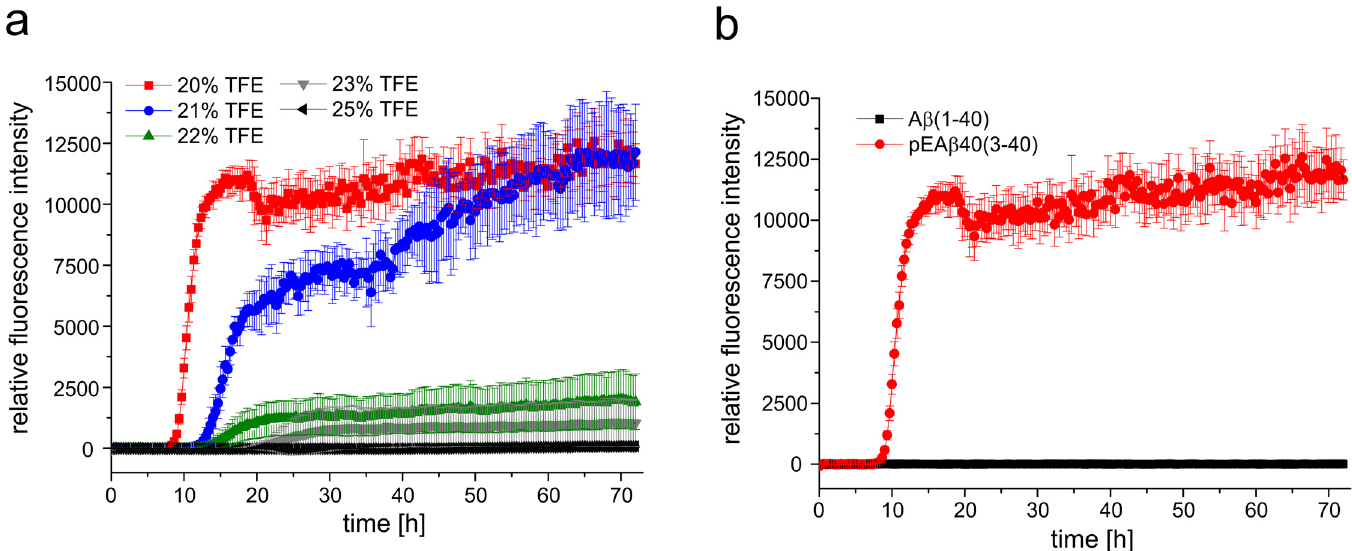
Fig 2. Aggregation kinetics of pEA β (3 – 40) and A β (1 – 40) in TFE. (a) 25 μ M of monomerized pEA β (3 – 40) were dissolved in buffer with various TFE contents (25%, 23%, 22%, 21% and 20% TFE in 50 mM potassium phosphate, pH 2.8) including 10 μ M ThT. pEA β (3 – 40) aggregated in 20% and 21% TFE but was significantly decreased in aqueous solution with higher TFE concentration. (b) 25 μ M of monomerized pEA β (3 – 40) and A β (1 – 40) were dissolved in buffer (20% TFE in 50 mM potassium phosphate, pH 2.8) including 10 μ M ThT. An increase in ThT fluorescence was observed for pEA β (3 – 40) but not for A β (1 – 40) within 72